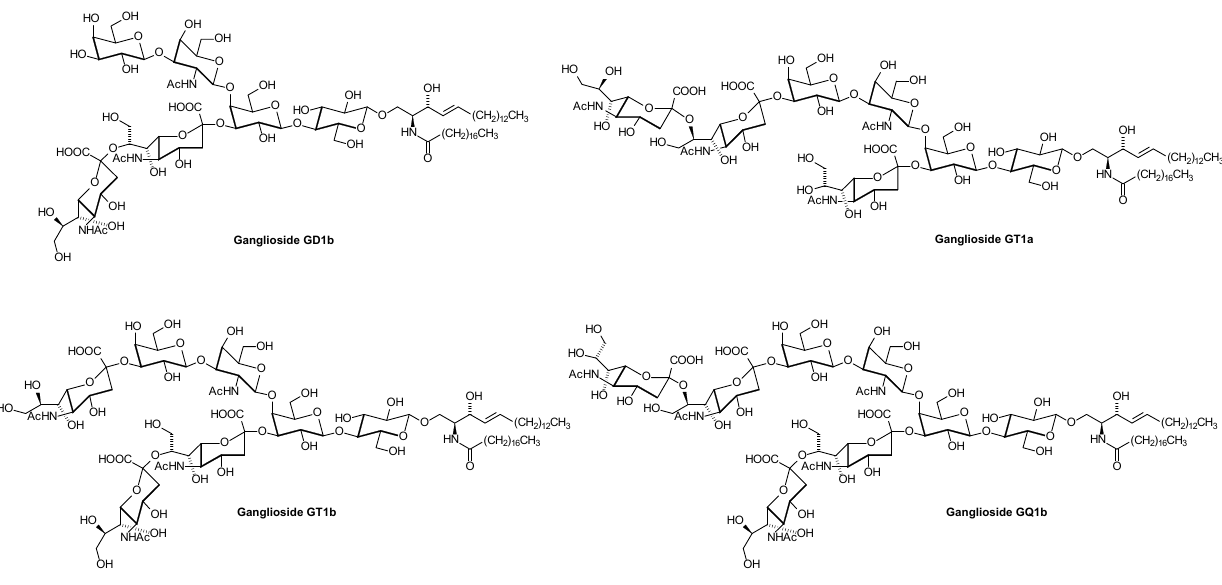
Figure 5. Structures of Oligosialogangliosides GD1b, GT1a, GT1b, and GQ1b. Only one of the various lipoforms is shown. Autoantibodies against ganglioside GM1 or different other gangliosides or combinations of them are the cause of Guillain-Barré- and Miller- Fisher syndrome